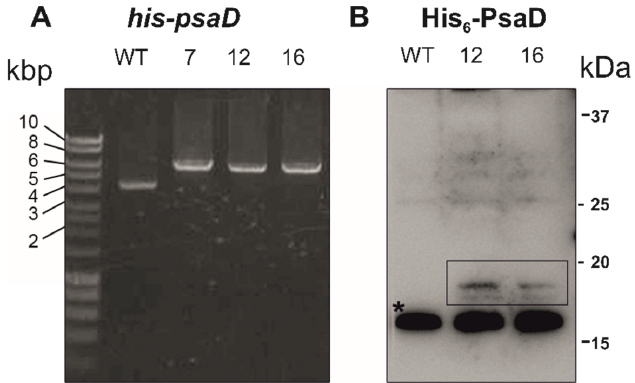
Table 1. Amino acid sequence of the His 6 -PsaD pre–pro-protein subjected to post-translation processing. Domain Amino Acid Sequence